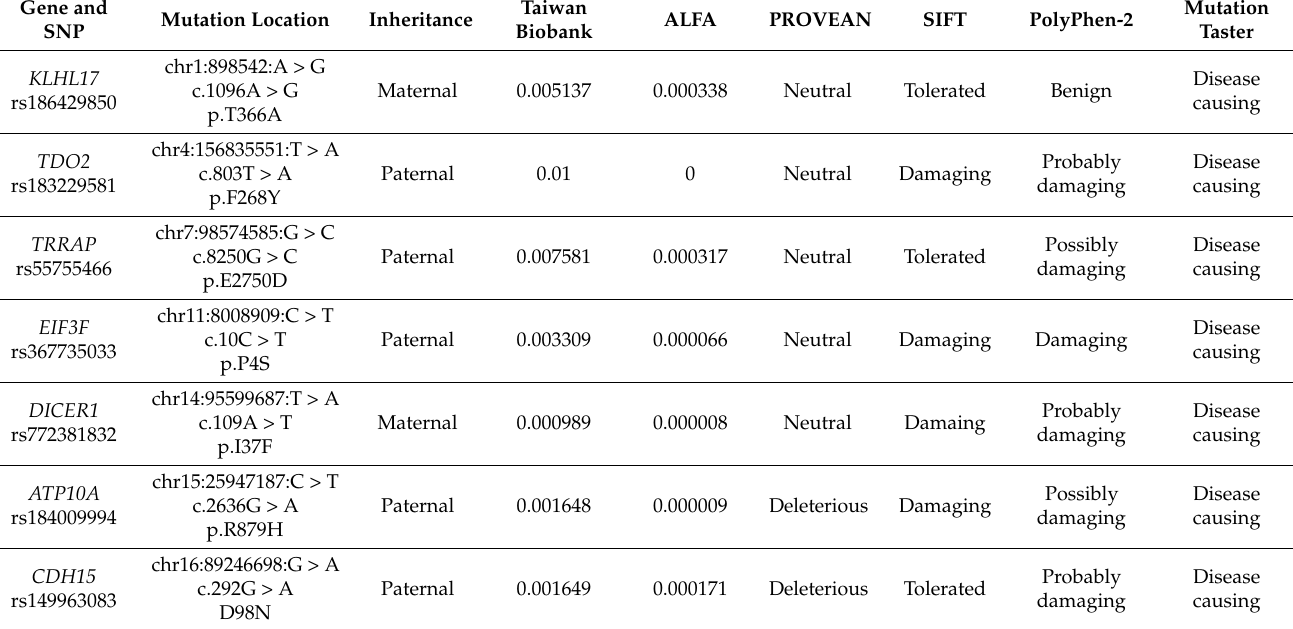
Table 3. Genetic information of the seven inherited rare variants identified in this